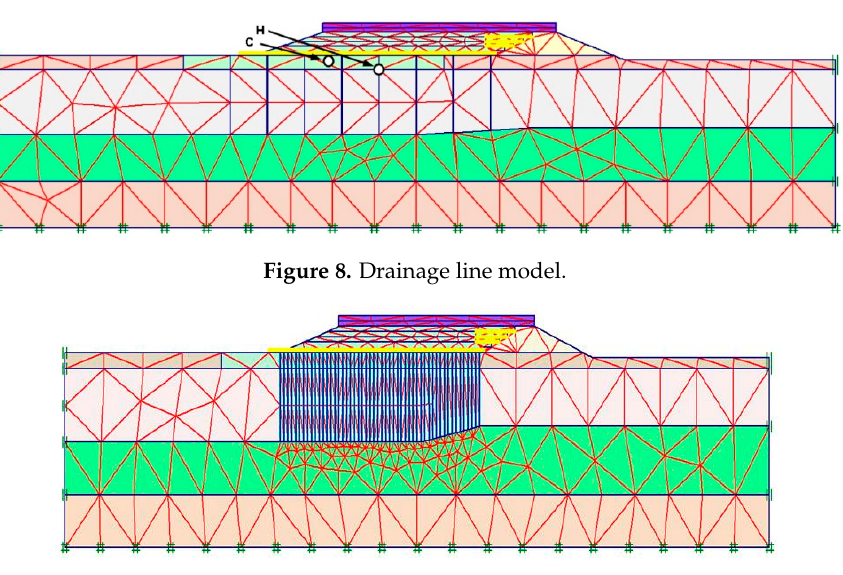
Figure 9. Equivalent sand-wall model (C and H are two feature points).